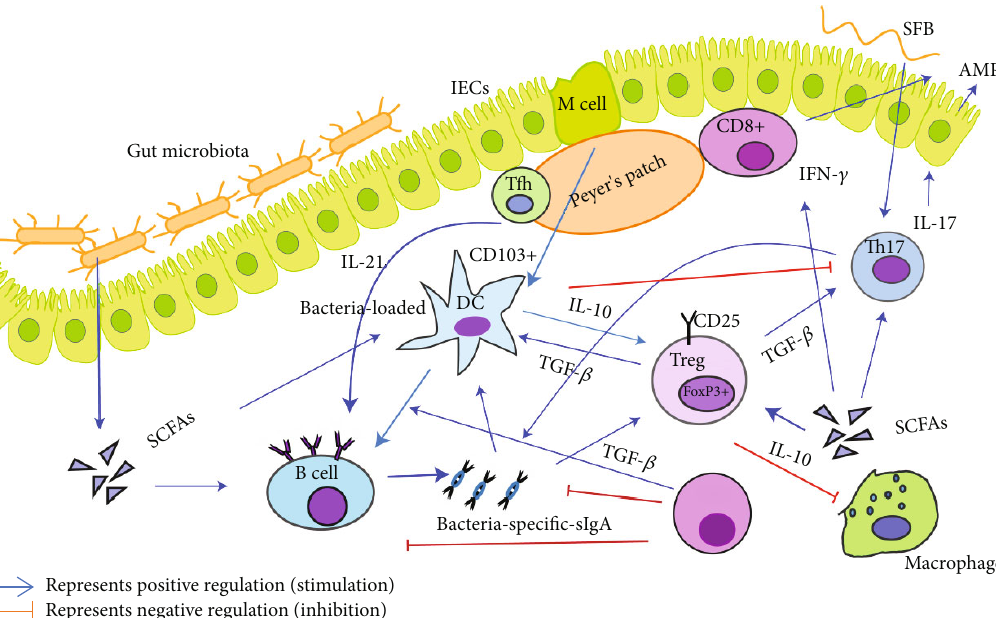
Figure 1: The intestinal microbiota modulate the intestinal mucosal adaptive immunity and interactions between immune cells. The intestinal microbiota, their components, and metabolites contribute to the regulation of innate and adaptive immune responses during homeostasis and dysbiosis states. Under homeostatic conditions, microbiota and microbial metabolites contribute to the intestinal immunological tolerance via Tregs and sIgA. Tolerogenic DCs contribute to the induction of Tregs and sIgA production by IL-10 secretion. Bacterial components such as SCFAs are potent inducers of Tregs and B cells and promote IFN- γ production from CD8 + T cells. Microbiota, SCFAs, and IL-21 secreted from the Tfh in the PP contribute to the secretion of bacteria-speci fi c sIgA. Segmented fi lamentous bacteria induce SFB-speci fi c Th17 cell production. Tregs modulate DCs and Th17 cells mediated by TGF- β . DCs and sIgA negatively regulate the function of Th17